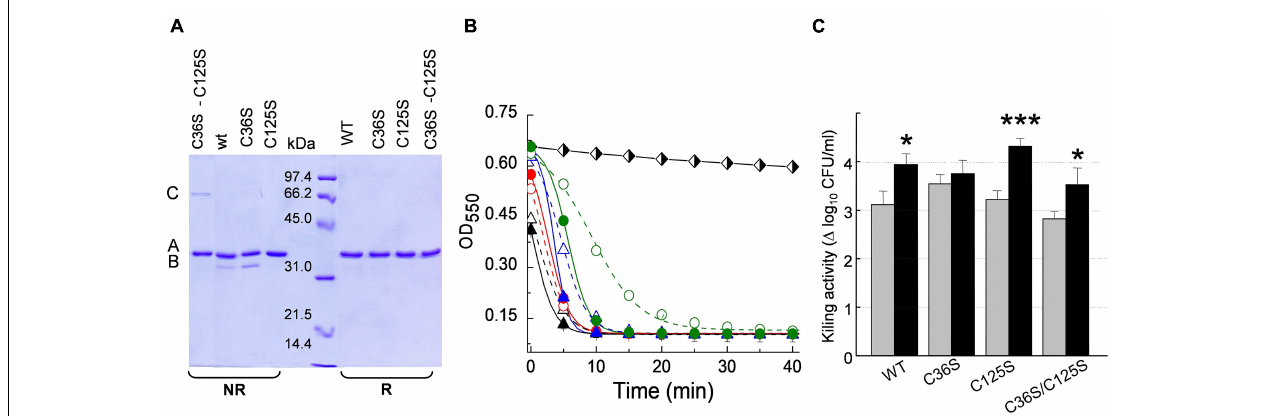
FIGURE 9 | Insight on DTT effect on Skl catalytic activity. (A) SDS-PAGE analysis of Skl WT and its Cys mutants under reducing (R) and non-reducing (NR) conditions (samples treated as in Figure 8A ). Bands B and A correspond to the monomer with and without an intramolecular Cys31–Cys125 disulfide bridge, and band C to a dimer with a Cys31–Cys31 intermolecular disulfide. (B) Lytic activity of Skl variants (5 µ g/ml) against R6 strain in PB and PB DTT 10 at pH 6.8 and 37 ◦ C (open and solid symbols, respectively). Symbols and solid lines depict representative experimental data after correction for control decay and fit to the Boltzmann sigmoid, respectively (WT: black triangles; C36S: red circles; C112S: blue triangles; C112S–C250S: green circles). Black and white diamonds illustrate control decay. (C) Killing activity of Skl variants in PB and PB DTT 10 (gray and black bars, respectively) in samples from (B) after 60 min incubation. Error bars represent standard deviations from three independent experiments. Asterisks mean a significant difference (* p < 0.05; *** p < 0.001) according to two-way ANOVA followed by Tukey post-test to compare with the control (PB); no significant differences were found between the mutants and the WT